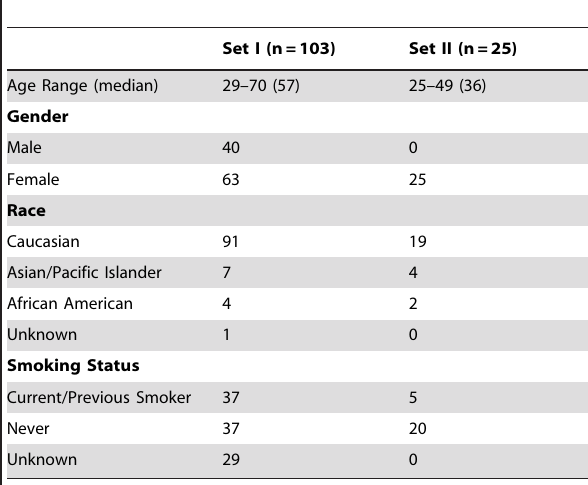
Table 1. Characteristics of study